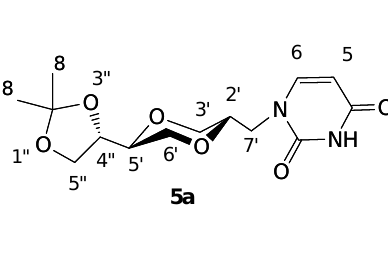
Figure 4. Structure 5a